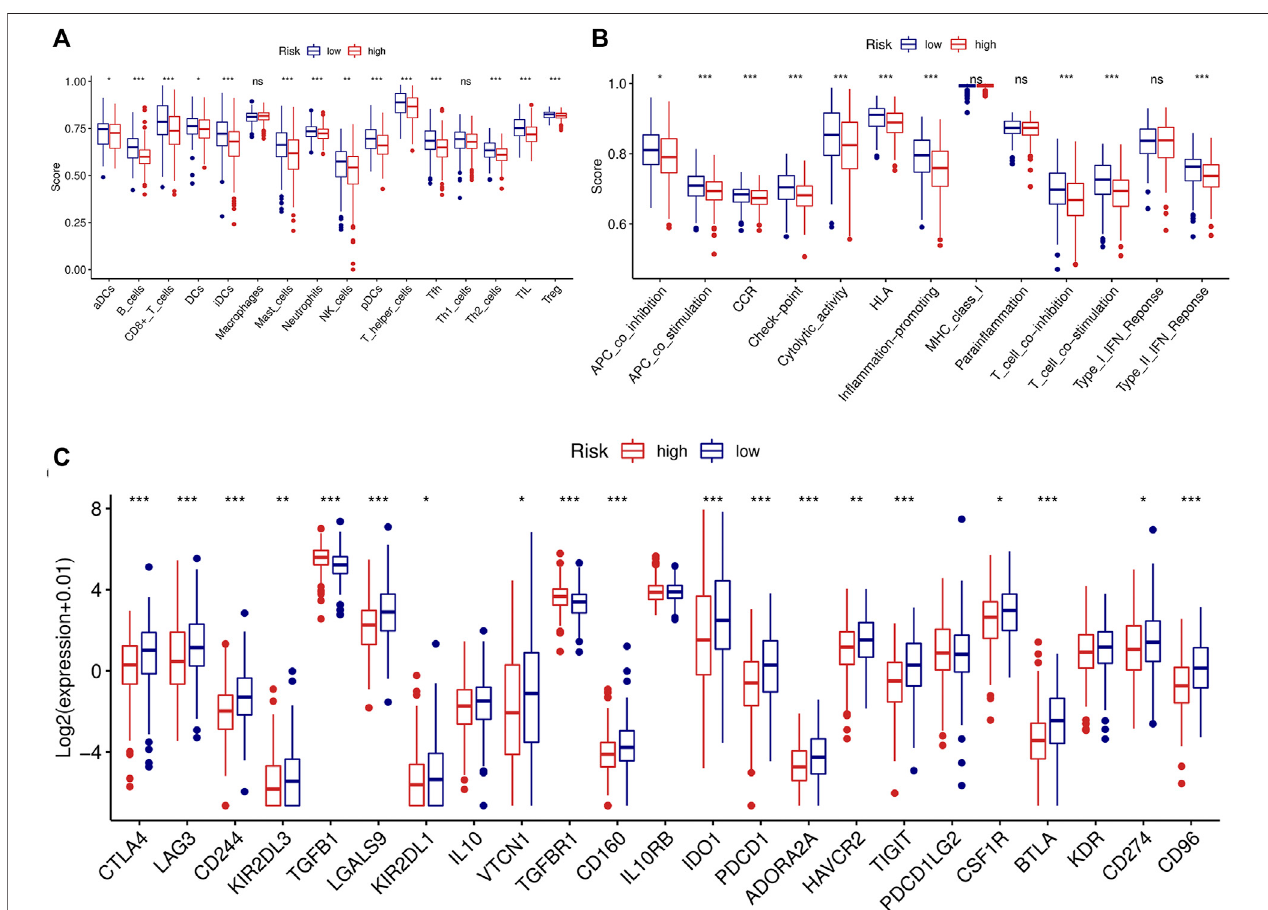
FIGURE 7 | Immune function, immune checkpoints, and immunotherapy analysis based on the signature. Comparison of immune cells (A) and immune function (B) between the high- and low-risk groups through the ssGSEA algorithm. (C) Differences in the expression of 23 immune checkpoints between the high- and low-risk groups. (D) KMcurveofOSinVanAllen ’ scohortgroupedbythesignature.KMcurvesofOS (E) andPFS (F) inBraunDA ’ scohort. (G) KMcurveofOSinRiazN ’ scohort. KM curves of OS (H) and PFS (I) in David Liu ’ s cohort. OS, overall survival; PFS, progression-free survival. (* p < 0.05; ** p < 0.01; *** p < 0.001; ns, not signi fi